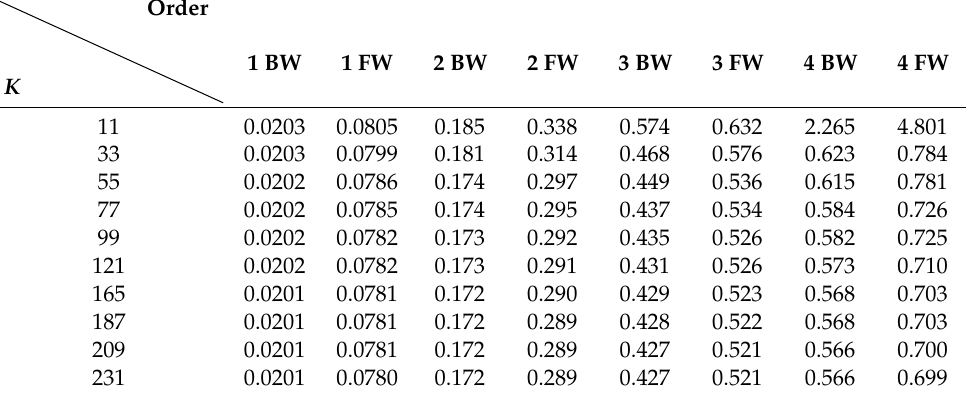
Table 3. Natural frequencies via modal discretization ( h = 200 Nms).